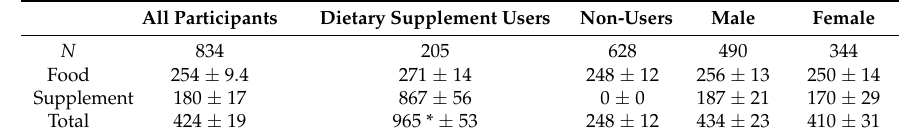
Table 2. Mean omega-3 intake (mg/day) at baseline.